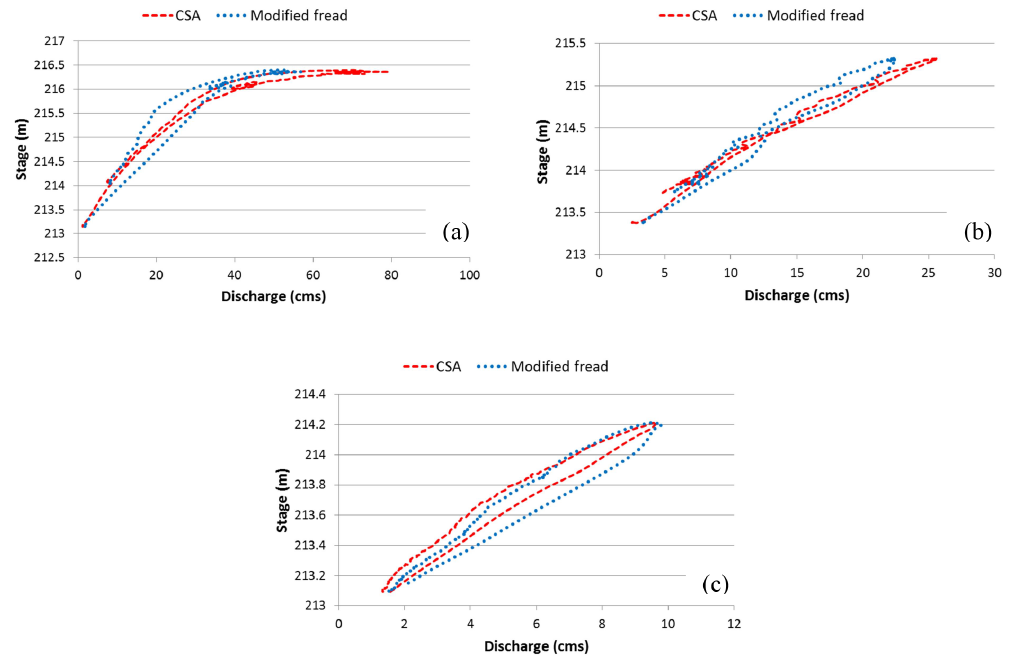
Figure 8. Comparison of hQRCs based on the CSA and modified Fread methods for the selected three events: (a) Event 1, (b) Event 2, and (c) Event 3. The horizontal axis represents discharges and the vertical axis represents stages at the downstream PT. USGS steady hQRC is not displayed herein as stage values are different because it is located 285m